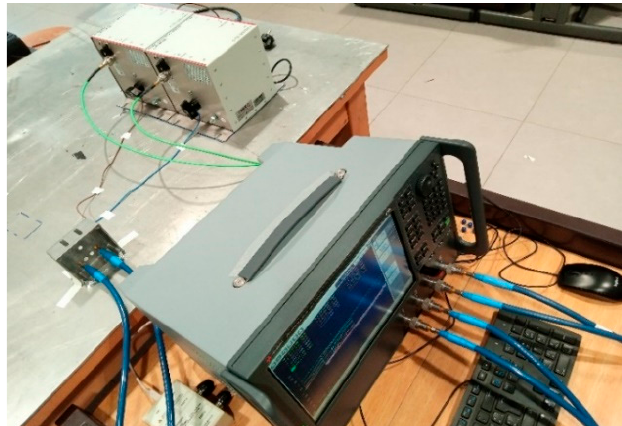
Figure 9. Experimental test bench to characterize the LISNs.